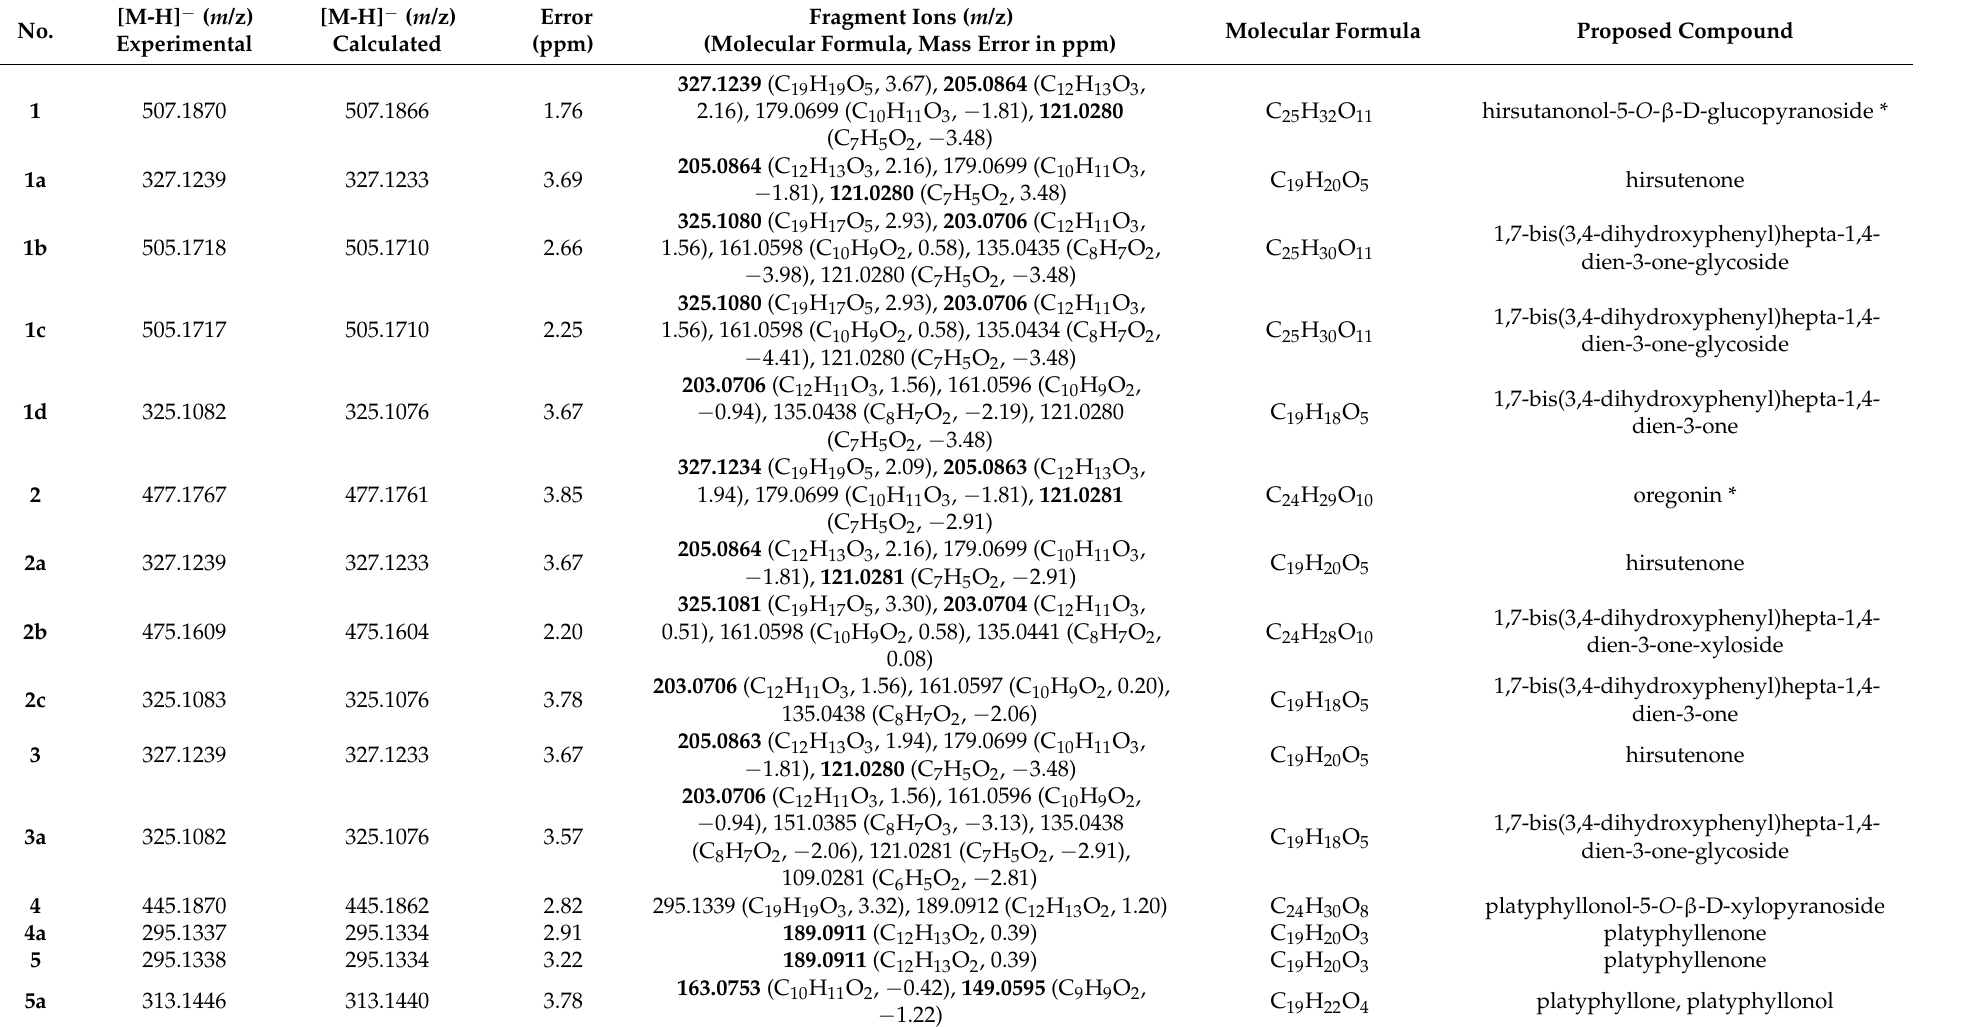
Table 1. HR-MS data of the diarylheptanoids and flavonoid compounds, and their degradation products.